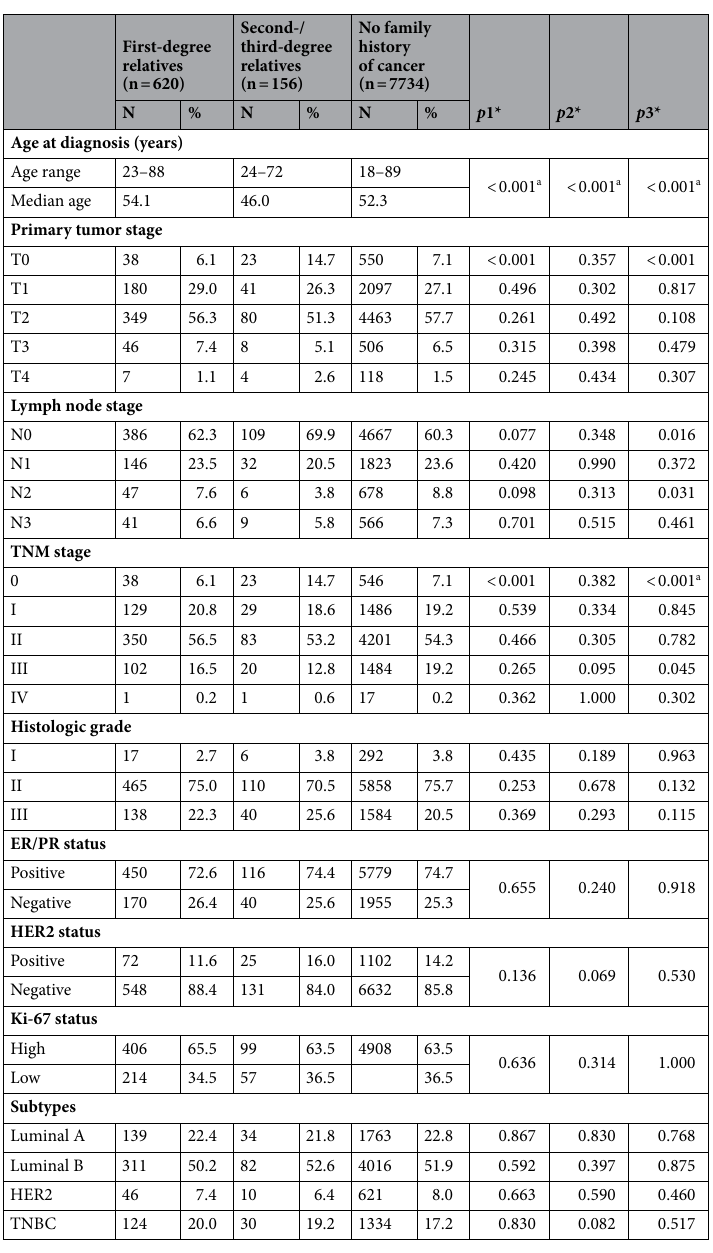
with Tamhane T2 correction. * p 1: F-FH vs. S/T-FH. p 2: F-FH vs. non-FH. p 3: S/T-FH vs.